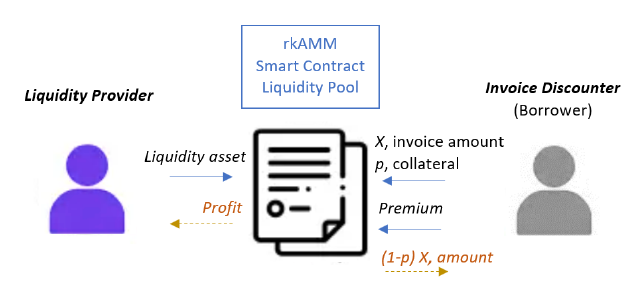
Figure 2. The rkAMM input and